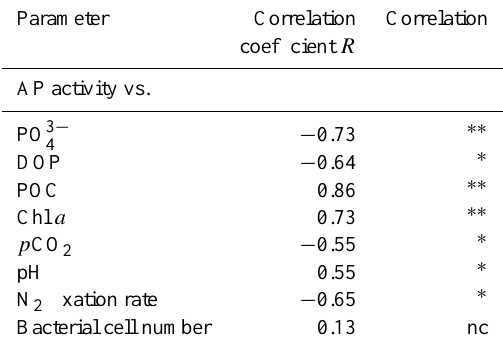
Table 2. Correlation of alkaline phosphatase activity (APA) with biomass of filamentous cyanobacteria (POC, Chl a ), PO 3 − pCO 2 , pH, N 2 fixation, and bacterial cell counts ( n = 36, except for PO 3 − ( n = 35) and N 2 fixation ( n = 32); R =correlation co- 4